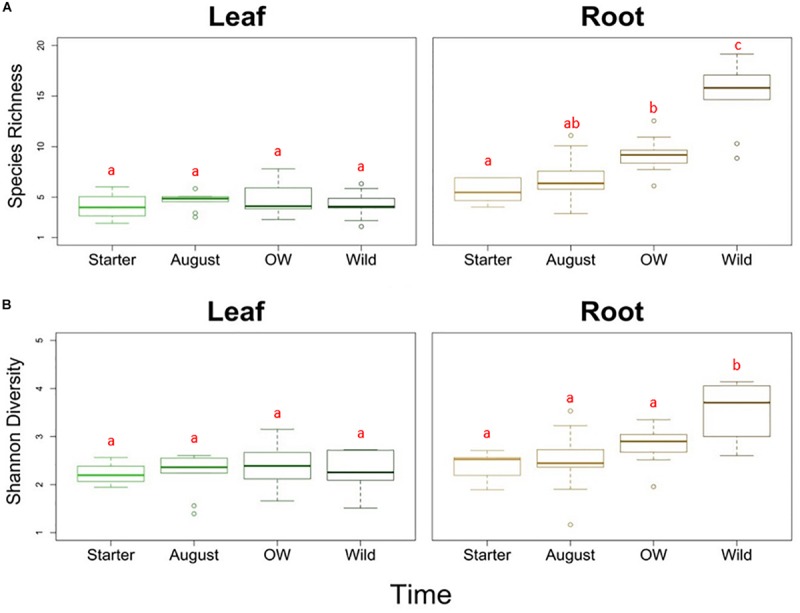
(A) Species richness and (B) Shannon diversity of endophytic bacterial communities in different tissues (leaf and root) and plant groups bait plants before field (Starter), bait plants after field (August), over-wintered bait plants (OW), and wild plants (Wild). Two-way ANOVA (p < 0.05) was used to determine the difference in the species richness and Shannon diversity between tissues and plant groups. Letters indicate the results from Tukey’s “Honest Significant Difference” test, where groups indicated with the same letter do not differ significantly.